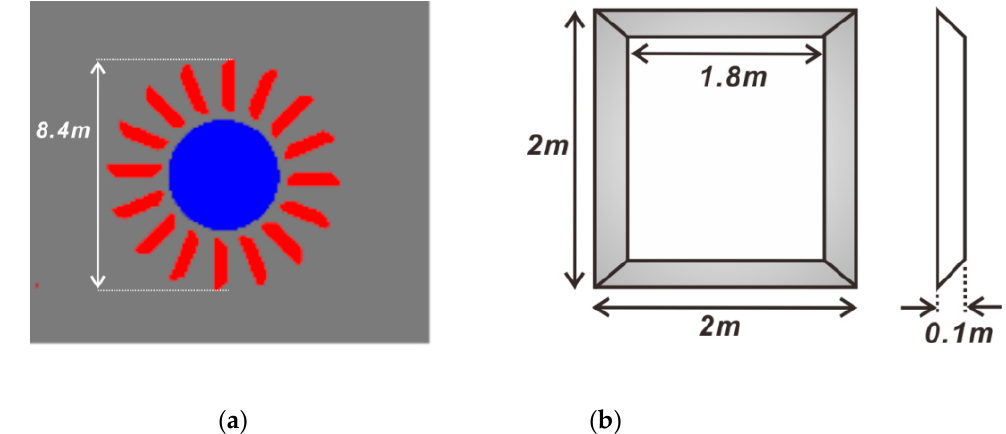
Figure 19. Dimensions of the hybrid mono-pile ( a ) Plan view, ( b ) Side